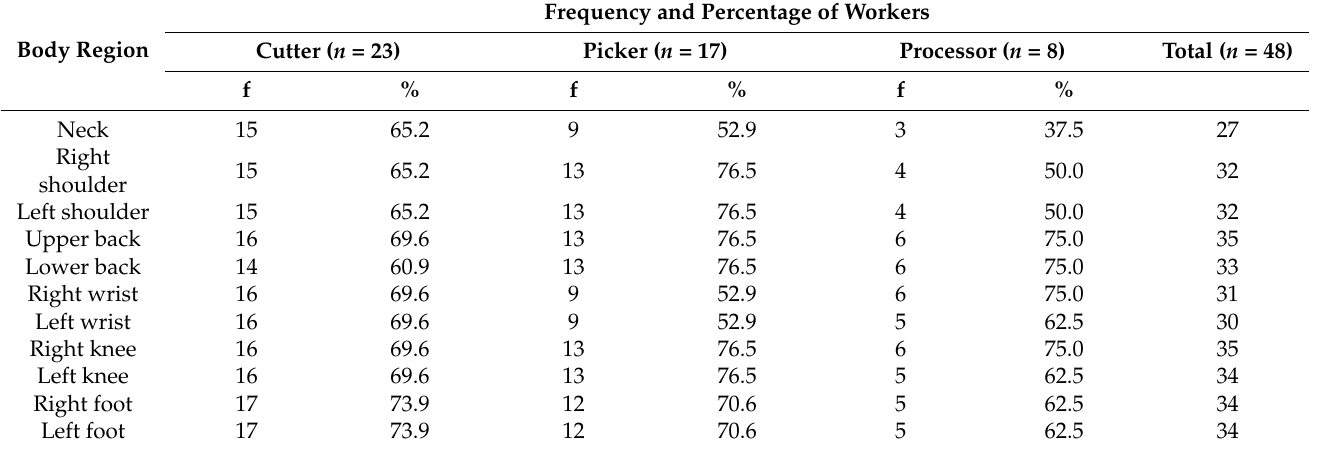
Table 5. Frequency (f) and percentage (%) of workers by job who perceived musculoskeletal symp- toms by body region for more than 30 days and all days during the last 12 months.